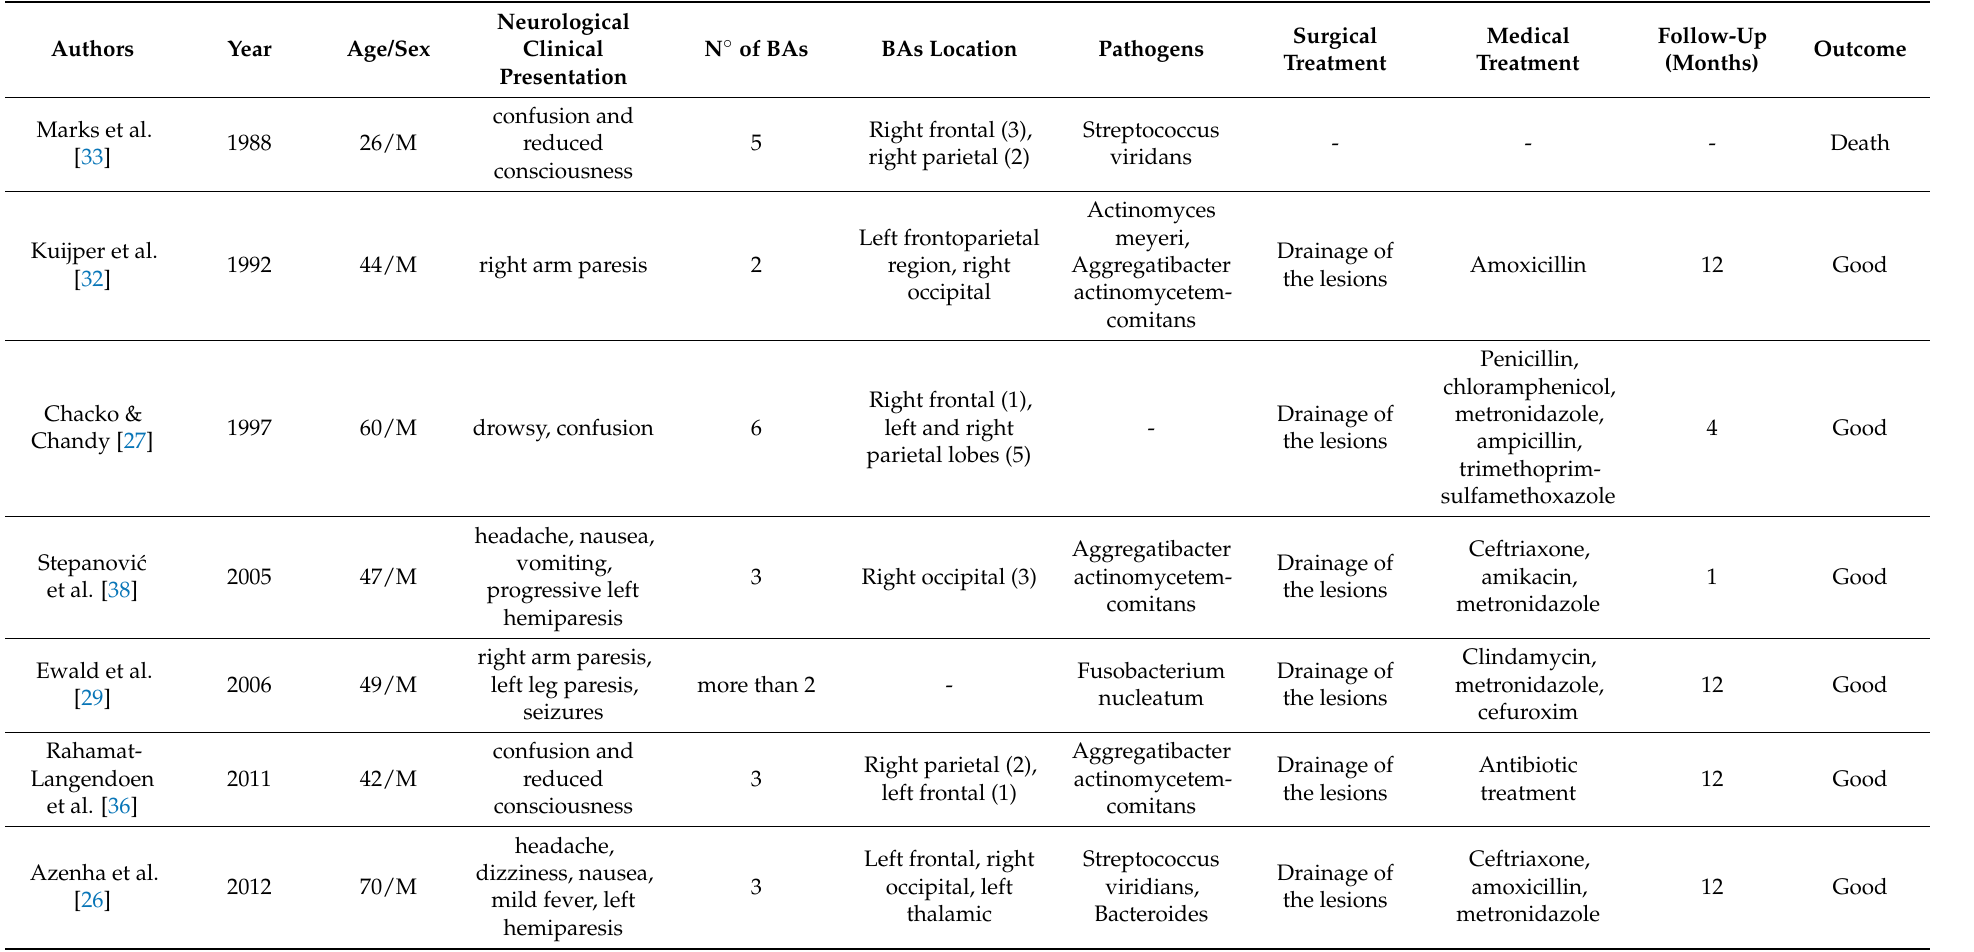
Table 2. Summary of studies included in the